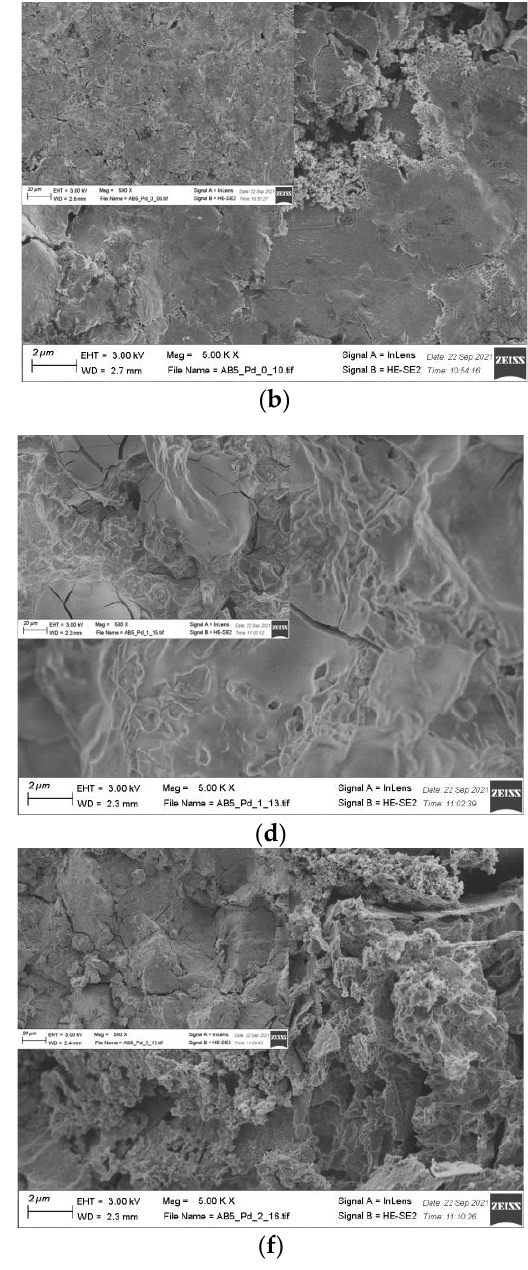
Figure 5. SEM images of ( a ) AB 5 ; ( b ) AB 5 -Pd-NPs; ( c ) AB 5 after electrochemical treatment in 1 M HMS/EMIm-MS; ( d ) AB 5 -Pd-NPs after electrochemical treatment in 1 M HMS/EMIm-MS; ( e ) AB 5 after electrochemical treatment in DEMA-TFO; ( f ) AB 5 -Pd-NPs after electrochemical treatment in DEMA-TFO; the insets — magnification 500×.